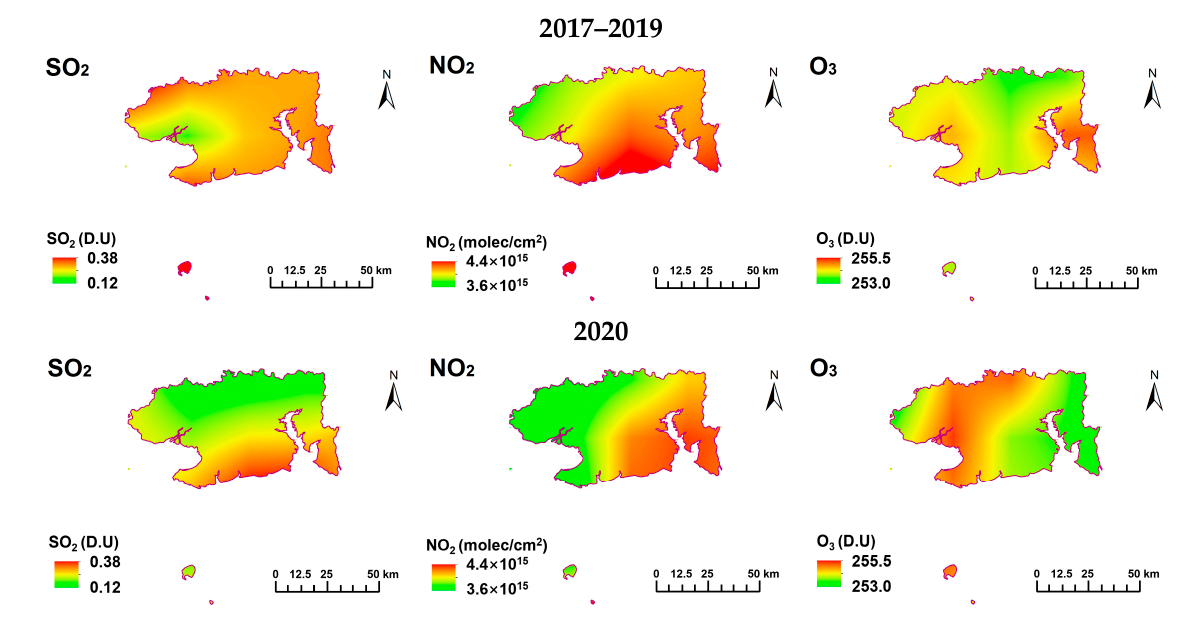
Figure 3. Spatial distribution of averaged VCD NO 2 , SO 2 and O 3 during the COVID-19 lockdown and those during the same period of 2017–2019.